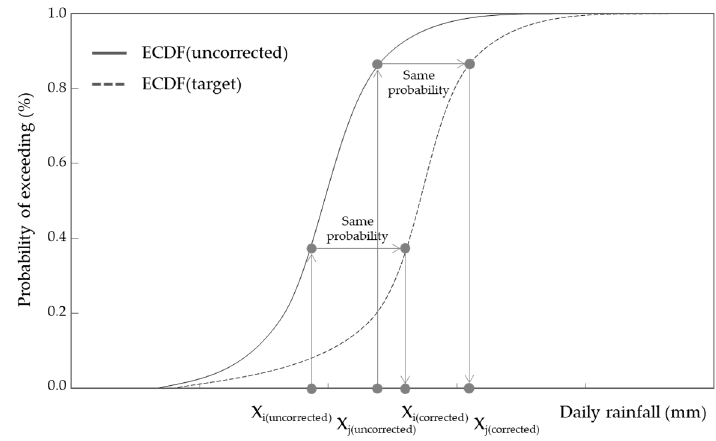
Figure 6. Schematic diagram of quantile mapping bias correction.